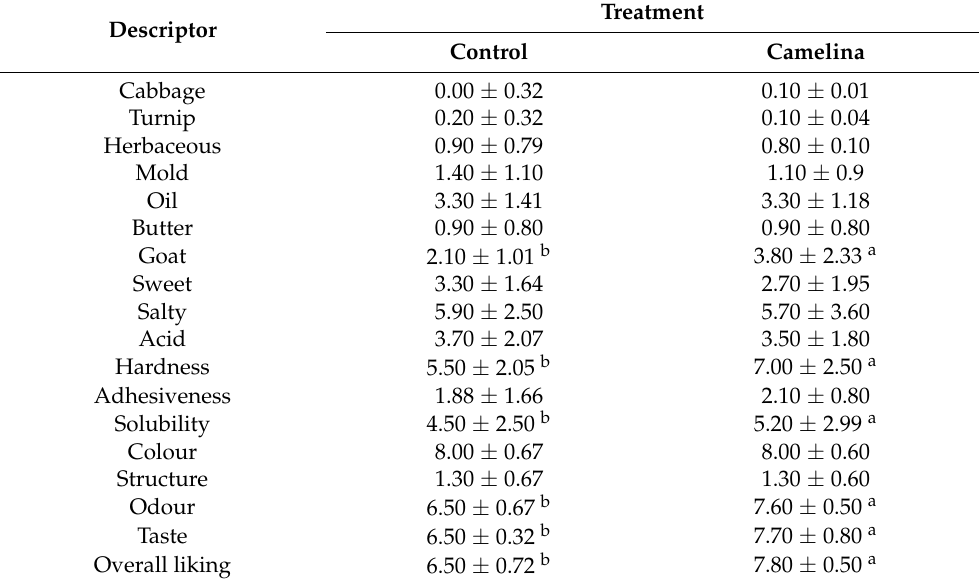
Table 5. Sensory properties of goat Caciotta cheese (mean ±